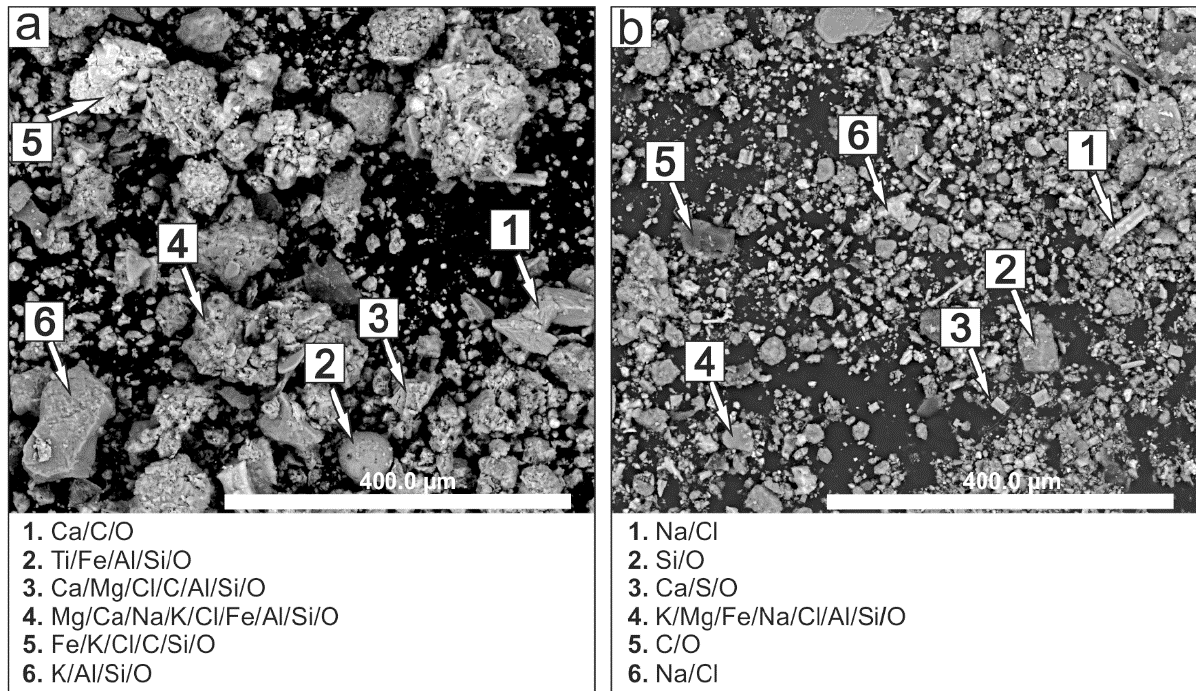
Figure 4. SEM images and EDS chemical analyses of airborne particles deposited in the entrance zone, E.3 ( a ) and the mine interior, I.5 ( b ).